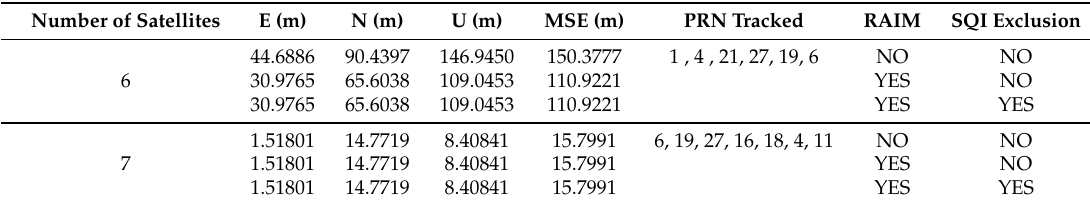
Table 7. Results for the scenario 2 with SQI thres = 0.7, no penalty weight and GDOP control enabled with k = 0.1 in case of 6 and 7 satellites in